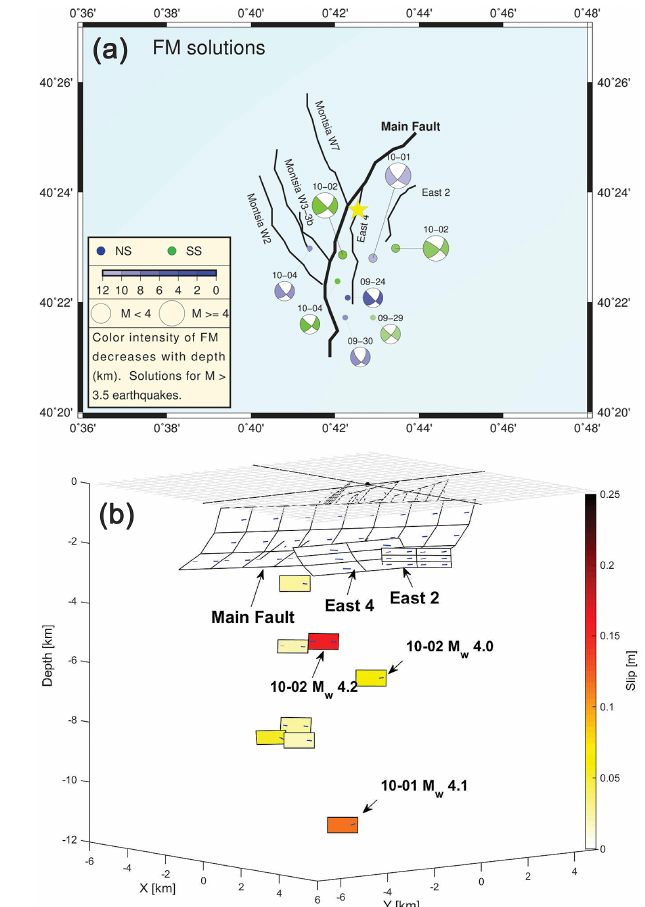
Figure 5. (a) Obtained solutions for the eight main events. Dots indicate the location of each beach ball plot. Mapped faults are in- dicated as well. In the legend, NS refers to mechanisms with nor- mal component, whereas the others (SS) are essentially pure strike- slips. (b) 3-D view of the fault model used in Coulomb calculations with both the FM and mapped faults and their associated slip in our modeling (only the FM faults slip). View from the SE. The coor- dinate origin (0, 0, 0) is shown in the mesh, and it corresponds to [0 ◦ 42 (cid:48) 40 ◦ 24 (cid:48) ] in the map